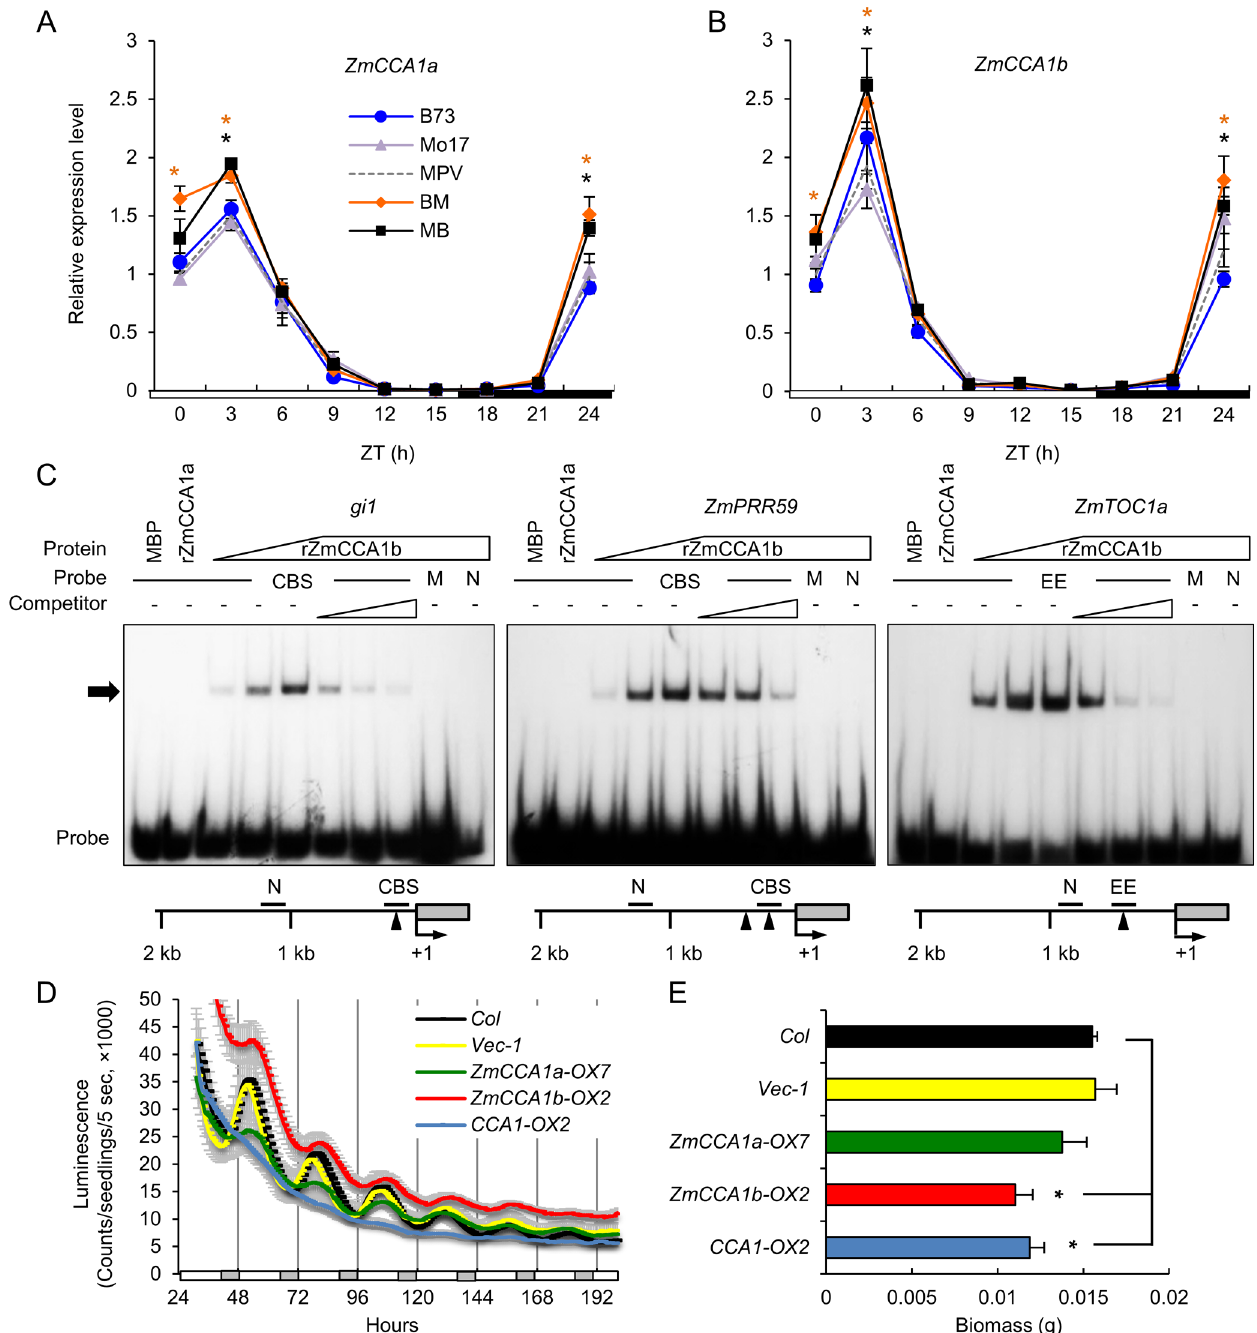
Fig 3. Molecular characterization of maize CCA1 homologs. (A and B) Relative expression levels (means ± SEM, n = 3) of ZmCCA1a (A) and ZmCCA1b (B) every 3 hours in a 24-hour period (light/dark cycle is shown below the histogram). Significant difference between hybrids and MPV was calculated using Student ’ s t-test, * p-value < 0.05. The relative expression level in MPV at ZT0 was set to 1. (C) Binding of recombinant ZmCCA1b (rZmCCA1b) to promoters of putative maize clock genes in vitro . Radioisotope-labeled DNA probes (endogenous promoter fragments) were incubated in the presence of MBP (1 pmol), rZmCCA1a (1 pmol), and rZmCCA1b (0.5, 1 and 2 pmol). Shifted protein-DNA complexes are indicated by the arrow. Competitors: 25X, 50X and 100X molar excess of unlabeled prompter DNA. M: DNA in which EE or CBS site was mutated; N: no EE or CBS site in the DNA fragment. Location of probes for each gene is shown below the gel image. Arrowheads represent EE or CBS site. Numbers are relative to the transcription start site (+1) and 5 ” UTR (grey box). (D) CAB2 : LUC activity rhythms in wild- type (Col-0), Vec-1 , ZmCCA1a-OX7 , ZmCCA1b-OX2 and CCA1-OX2 under constant light (means ± SEM, n = 12 – 16). White and grey bars represent the subjective day and night, respectively. T2 plants were used in the analysis. (E) Dry aerial biomass of wild-type (Col-0), Vec-1 , ZmCCA1a-OX7 , ZmCCA1b-OX2 and CCA1-OX2 . Dry biomass (grams) was measured 35 DAP in the diurnal conditions (means ± SEM, n = 10).